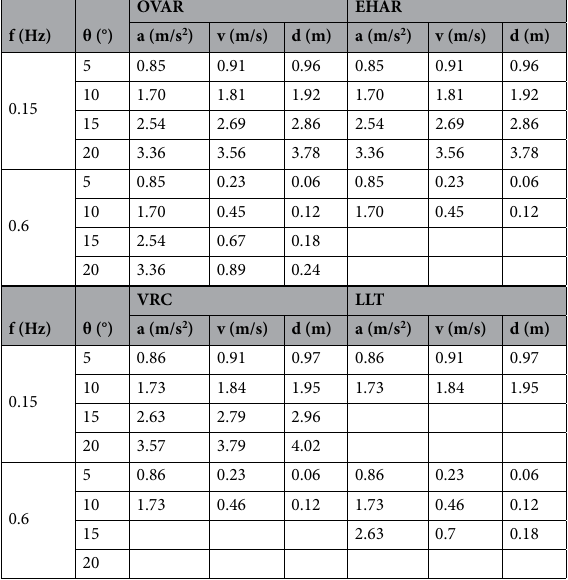
Table 3. Stimulus parameters for the various motion paradigms at each tilt angle. F frequency, a linear acceleration, v linear velocity, d peak-to-peak amplitude, θ tilt